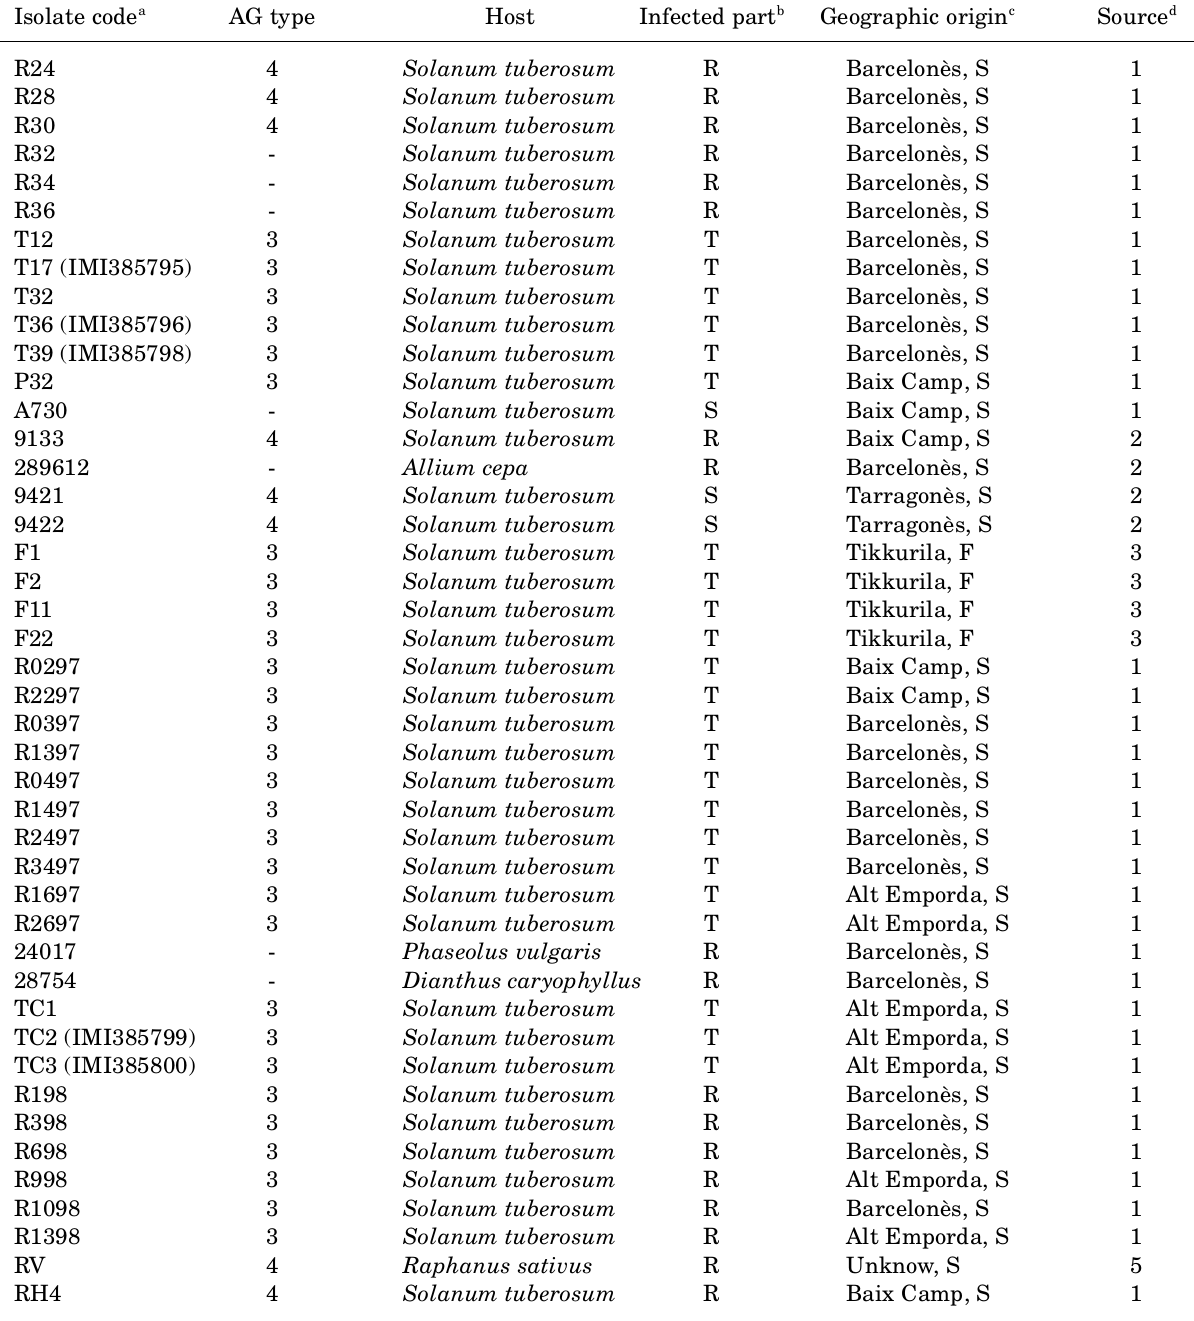
Table 1. Isolates of Rhizoctonia solani studied. Isolate code